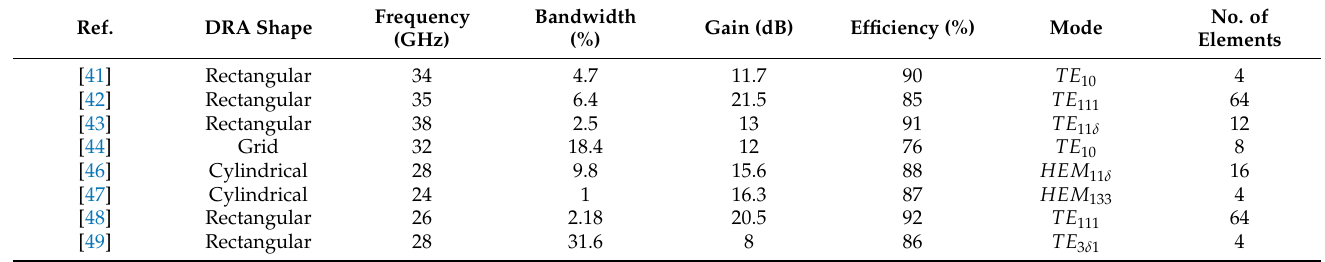
Table 2. Comparison between the performance of array linear polarized DRAs at